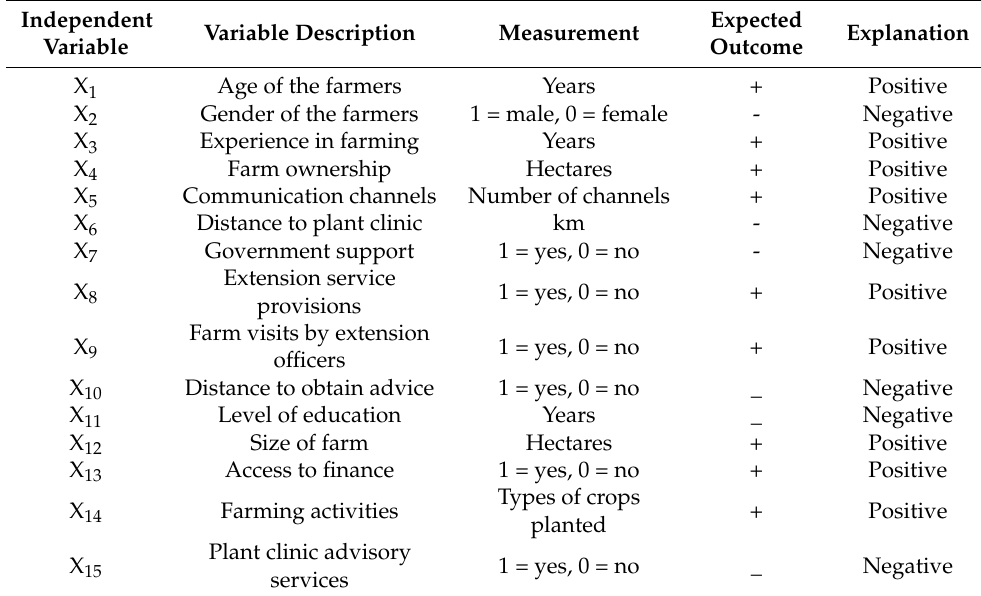
Table 1. Explanation of independent variables determining smallholder farmers’ awareness and accessibility in the logit regression